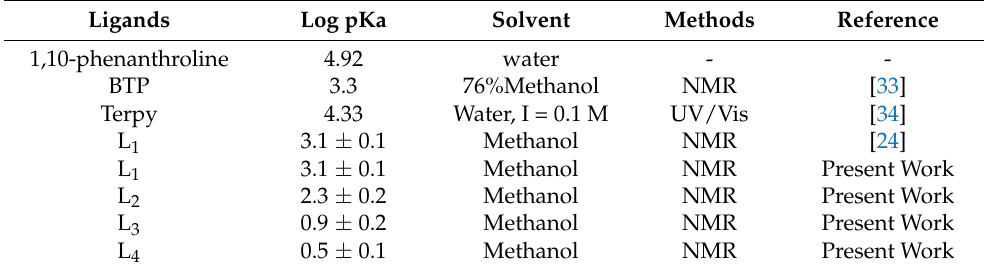
Table 1. Protonation constant of